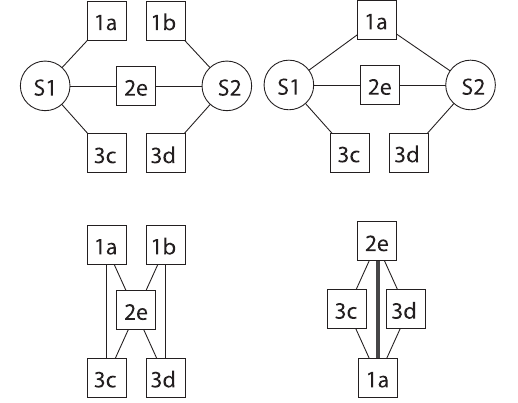
FIG. 3. Two example schematics of how a bipartite network (top row) is projected into a response network (bottom row).